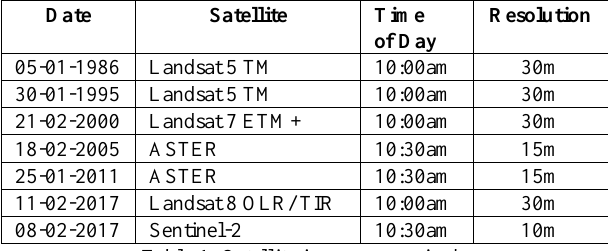
Table 1: Satellite imagery